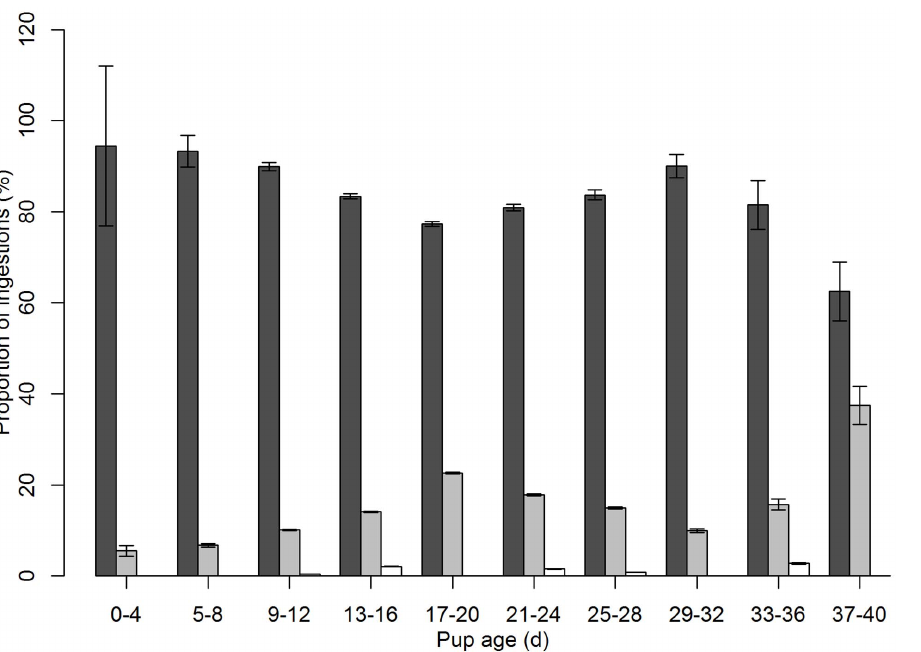
Figure 5. Relative occurrence of each ingestion type as a function of pup age. PDER events ( n =1723) from pups of known age ( n =34) were used to calculate the proportion of ingestions. Dark-grey, light-grey and white bars represent milk, seawater and solid food ingestions, respectively. Data are presented as means 6 s.e.